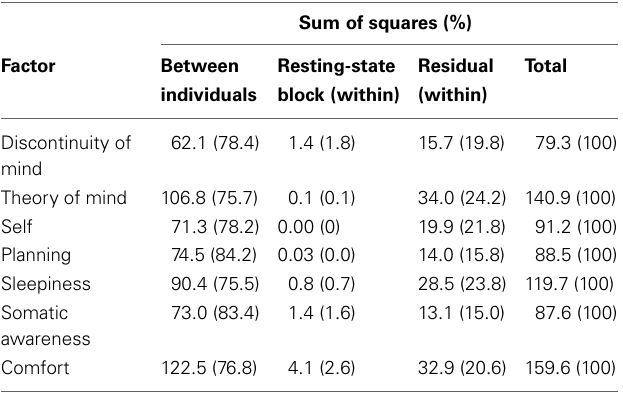
FIGURE 5 | Cognition over two resting-state sessions was strongly and positively correlated, yet displayed substantial between-subject variation. As such, variation in resting-state cognition is primarily due to inter-individual differences. Note: to aid visualization, a minute amount of white noise ( M = 0 . 1 ± 0 . 05 SD) was added to the data points. Table 7 | Variance decomposition of resting-state cognition in fMRI group ( n =